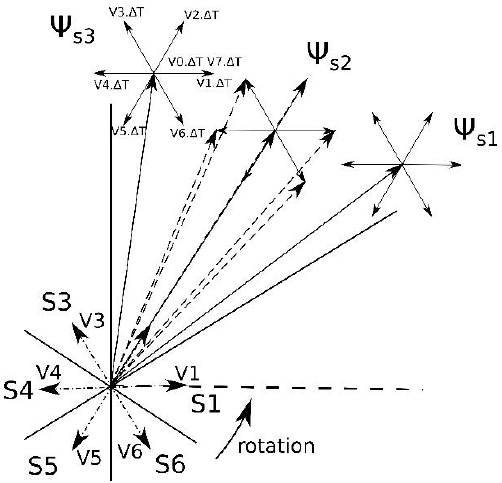
Figure 4. Applied voltage vectors in predictive torque control (PTC). All eight voltage vectors can be applied in any flux sector.